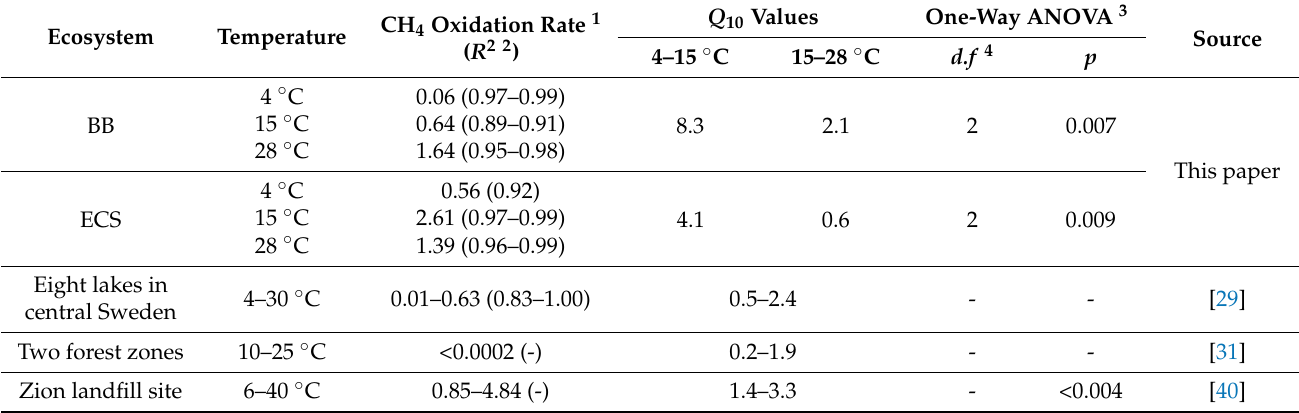
Table 2. Potential CH 4 oxidation rates ( μ mol gdw − 1 d − 1 ), Mean ( R 2 ), Q 10 values, and one-way ANOVA.